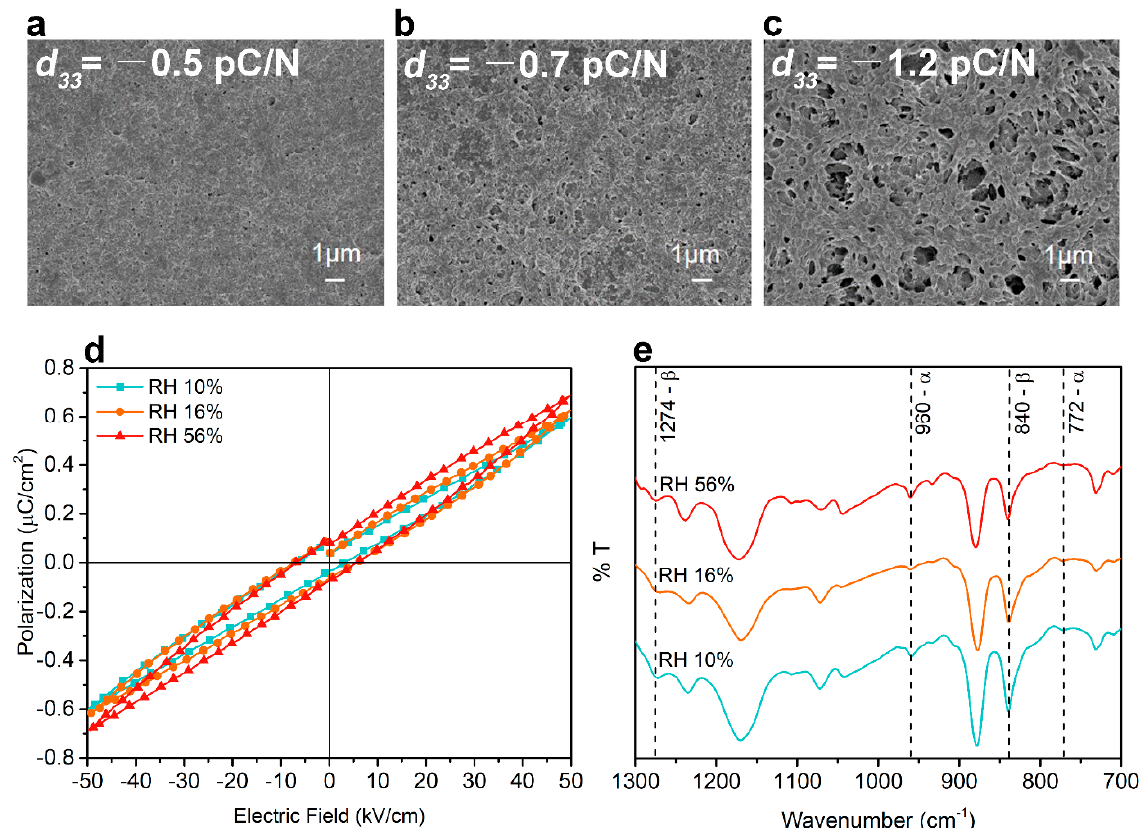
Figure 2. Surface morphology characterized by scanning electron microscopy (SEM) of PVDF-coated polycaprolactone (PCL)-tricalcium phosphate (TCP) films fabricated at a relative humidity (RH) of ( a ) 10%, ( b ) 16%, and ( c ) 56%. ( d ) Repre- sentative ferroelectric polarization–electric field (P–E) hysteresis measured under an applied field up to 50 kV/cm. ( e ) FTIR spectra of PVDF-coated PCL-TCP films